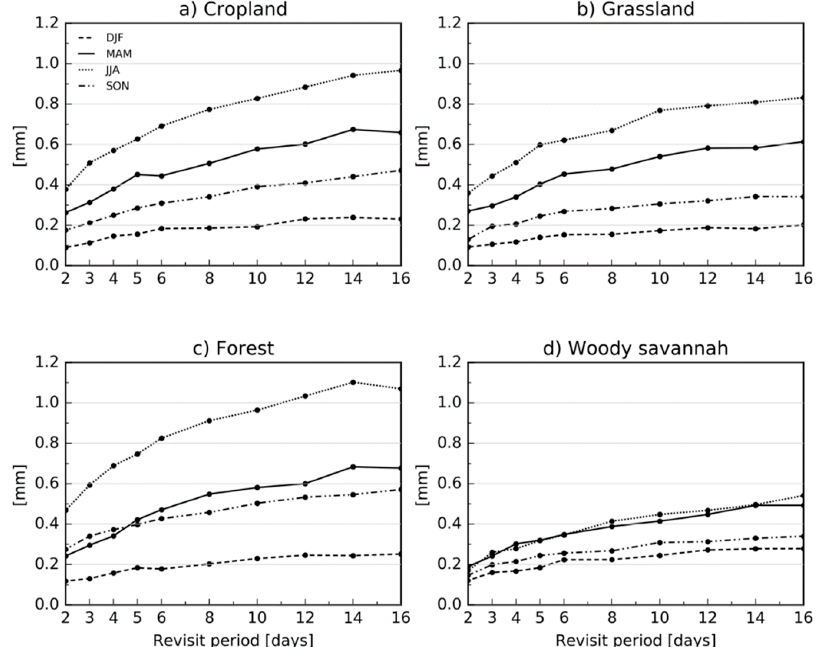
Figure 8. Root Mean Square difference (in mm per day) between ET derived from the one-day revisit dataset and derived from the different revisit scenarios for a 13:00 simulated satellite overpass time for different vegetation types: ( a ) Cropland, ( b ) grassland, ( c ) forest and ( d ) woody savannah.